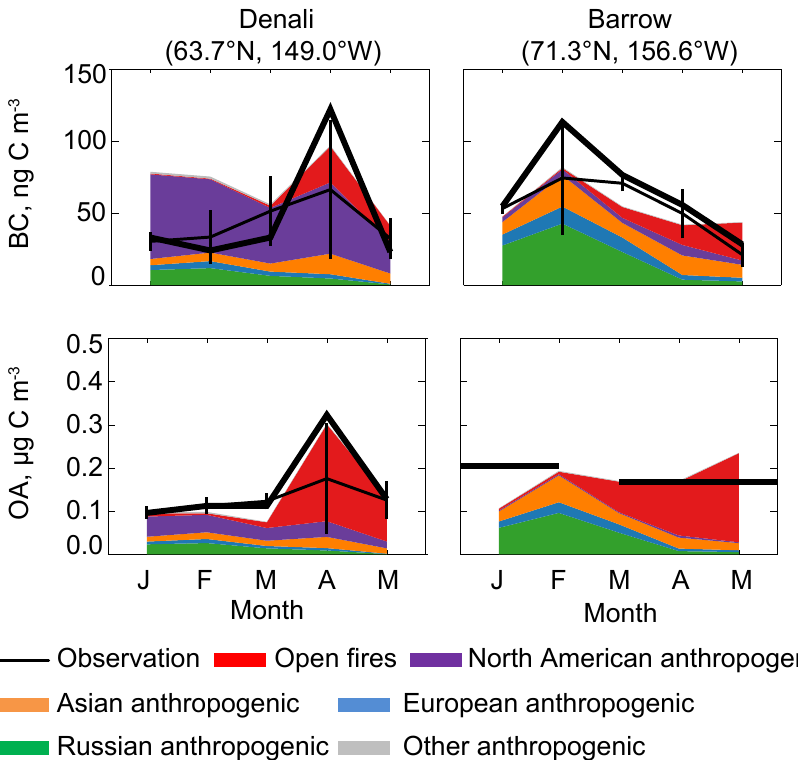
Fig. 10. Seasonal variation of BC and OA surface air concentrations at Denali and Barrow in Alaska. The thick black lines are monthly mean observations for 2008. The thin black lines are monthly mean observations for 2007–2009 with vertical bars representing interannual standard deviations. The thick line for OA at Barrow represents seasonal mean concentrations in Nov 2008–Feb 2009 and Mar–Jun 2008 from P. Shaw et al. (2010). Additive model contributions from different sources in the 2008 simulation are shown in